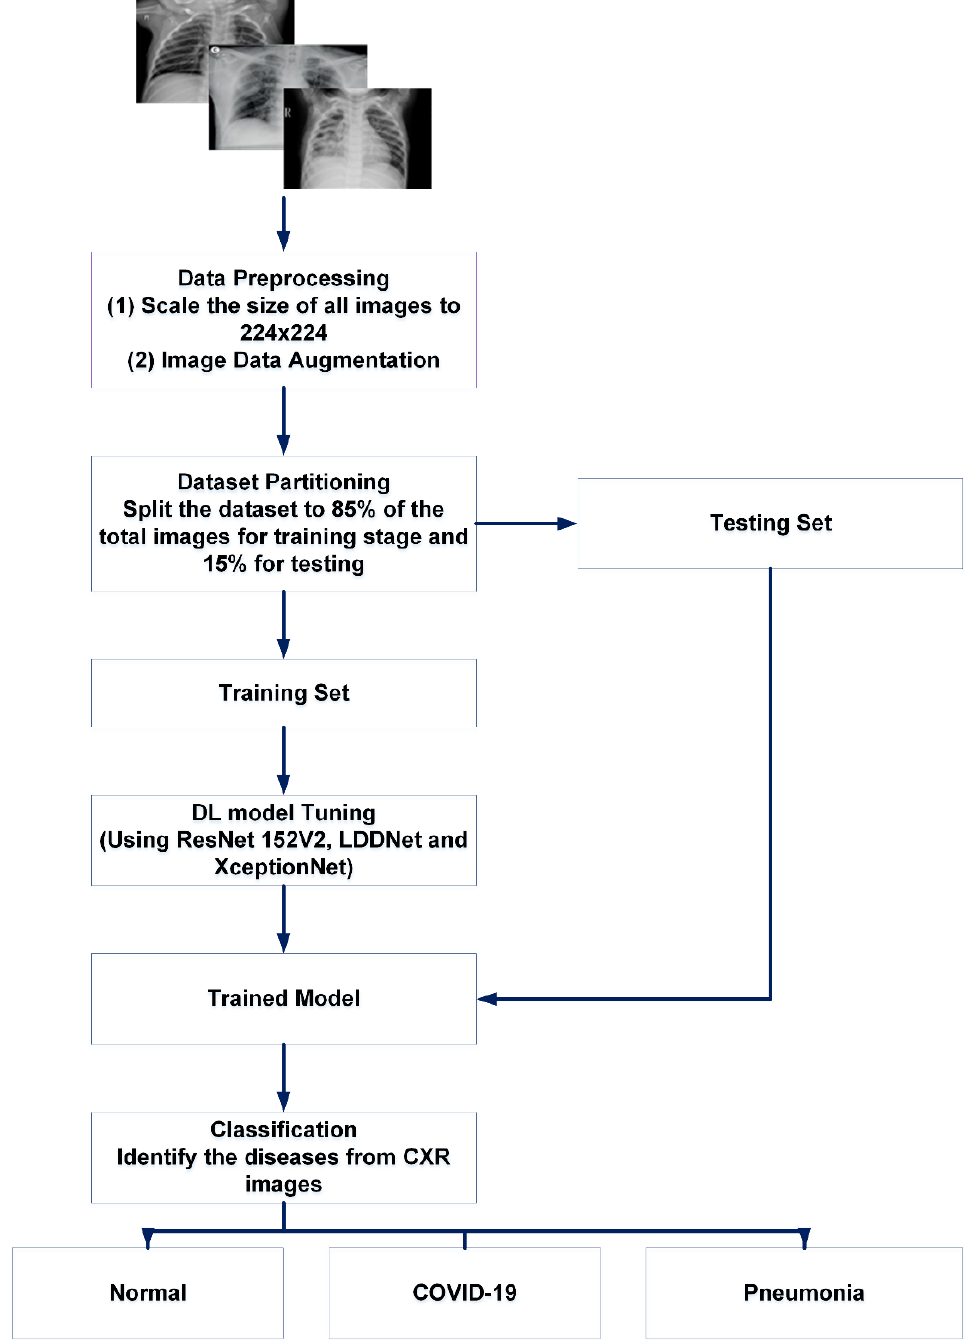
Figure 4. Basic summary of our proposed work for X-ray images.